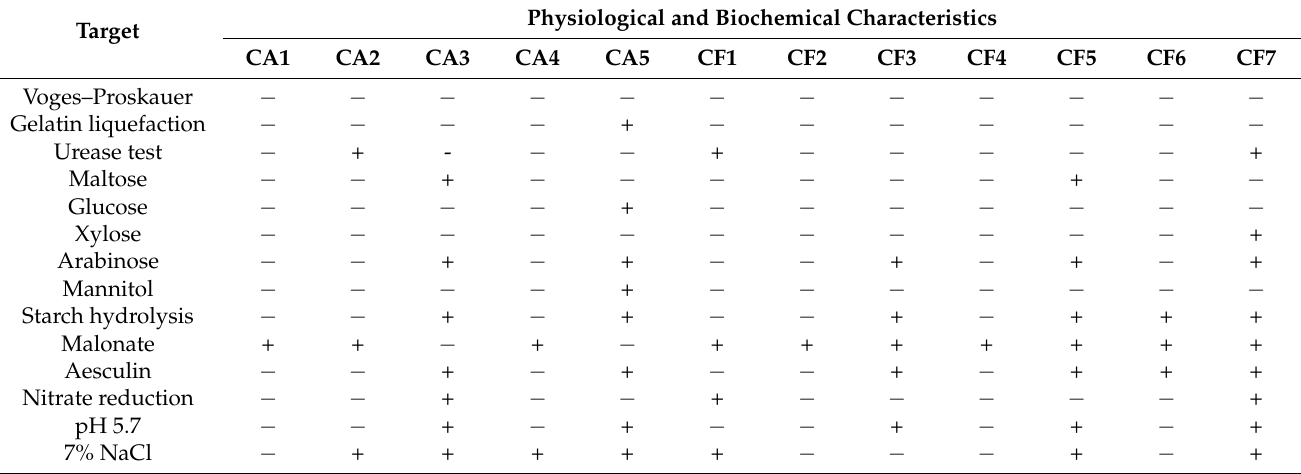
Table 3. Physiological and biochemical characteristics of phycosphere bacteria isolated from C. dentata